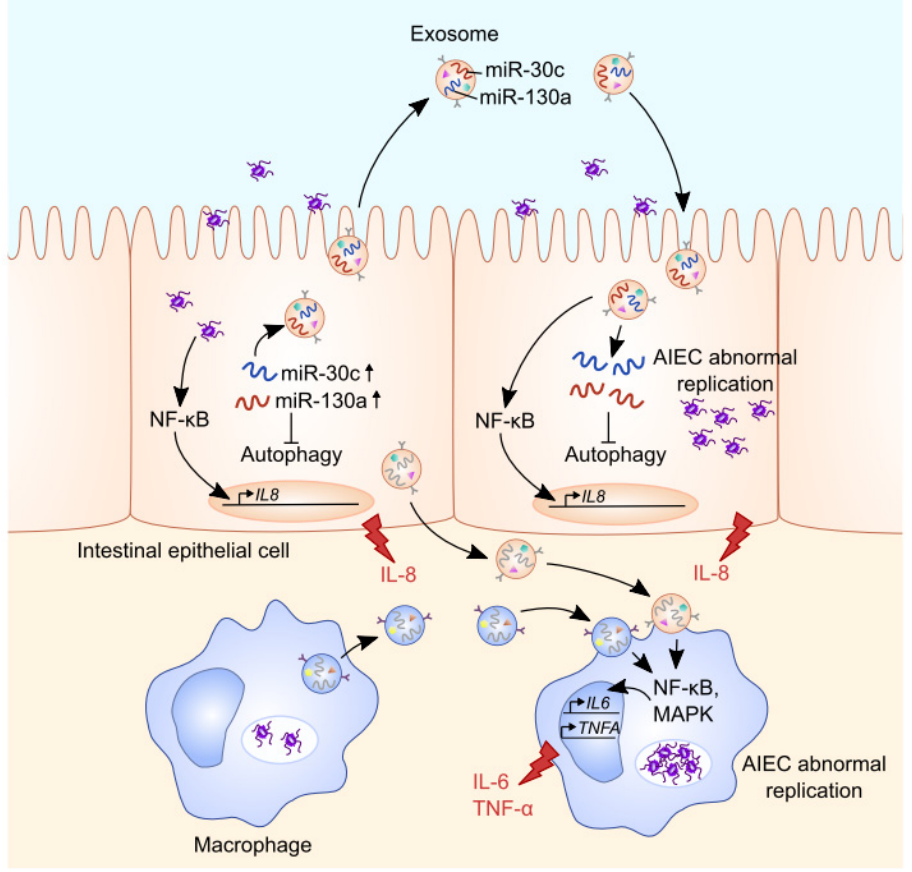
Figure 1. Role of exosomes in intercellular communication during infection with Crohn disease (CD)-associated adherent-invasive E. coli (AIEC) . AIEC infection leads to increased levels of miR-30c and miR-130a in intestinal epithelial cells (IECs), thereby inhibiting autophagy. These miRNAs can be transferred via the exosomal shuttle from cell to cell, impairing autophagy-mediated AIEC